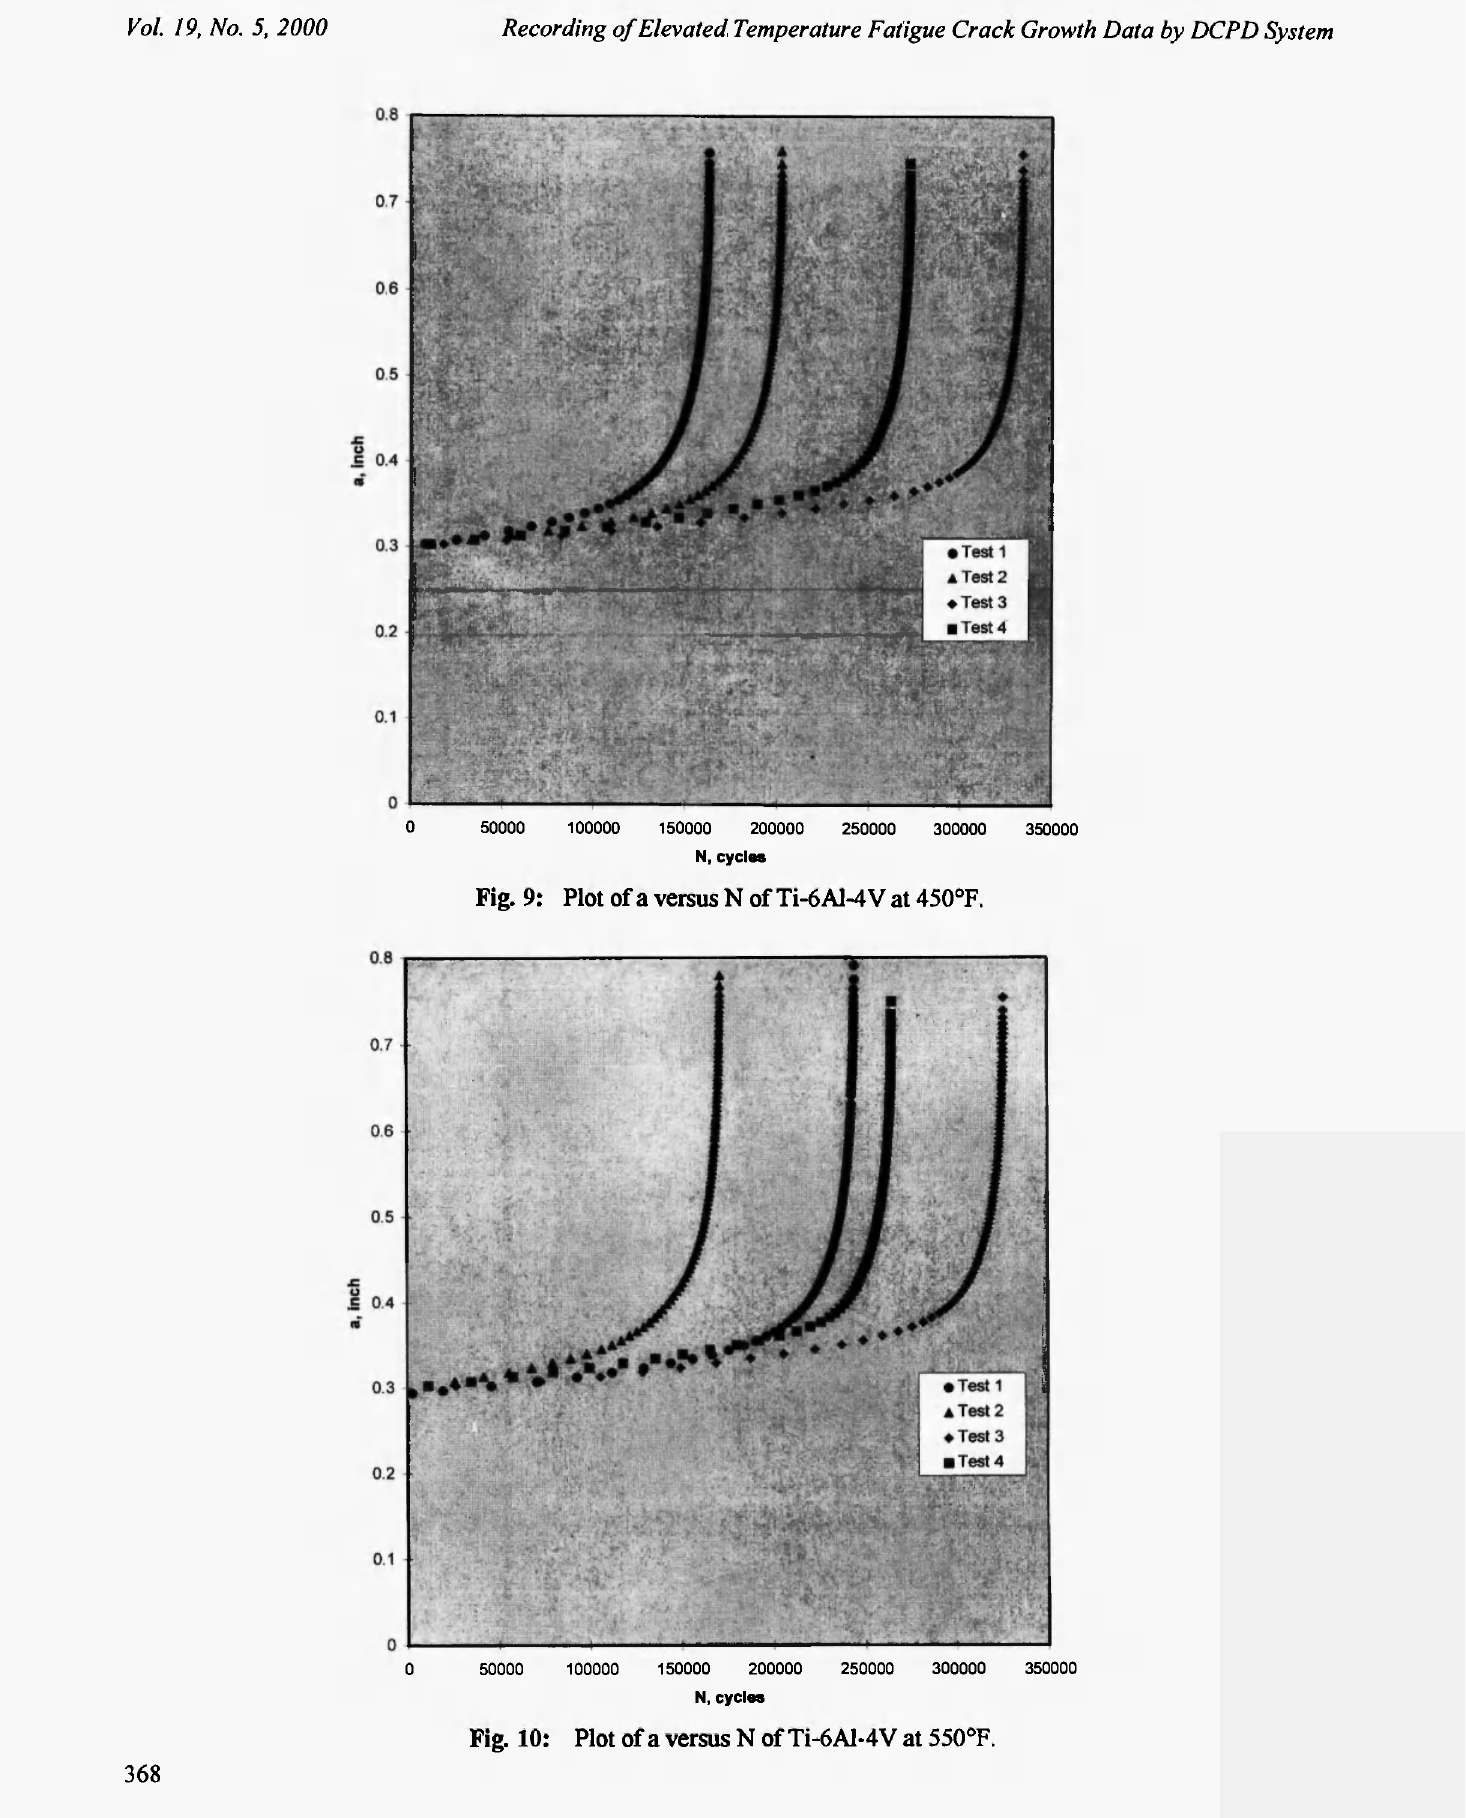
Fig. 9: Plot of a versus Ν of Ή-6Α1-4 V at 450°F.